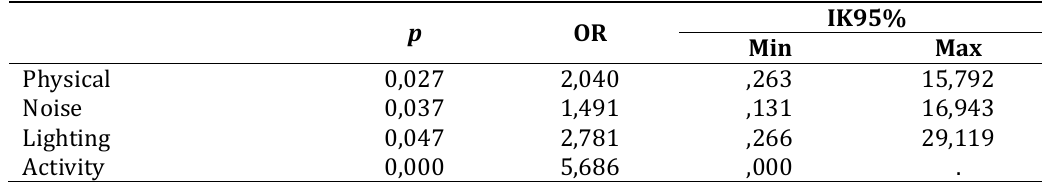
Multivariate Analysis of Factors that Affect Sleep